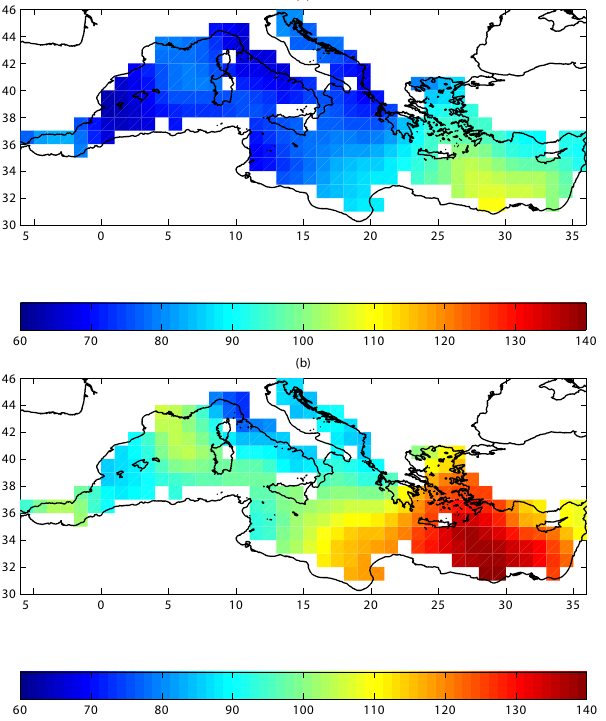
Fig. 4. Mean annual distribution of evaporative heat flux at the sea surface corresponding (a) to Kondo scheme and (b) to neutral Budyko scheme. Units are W/m 2 .